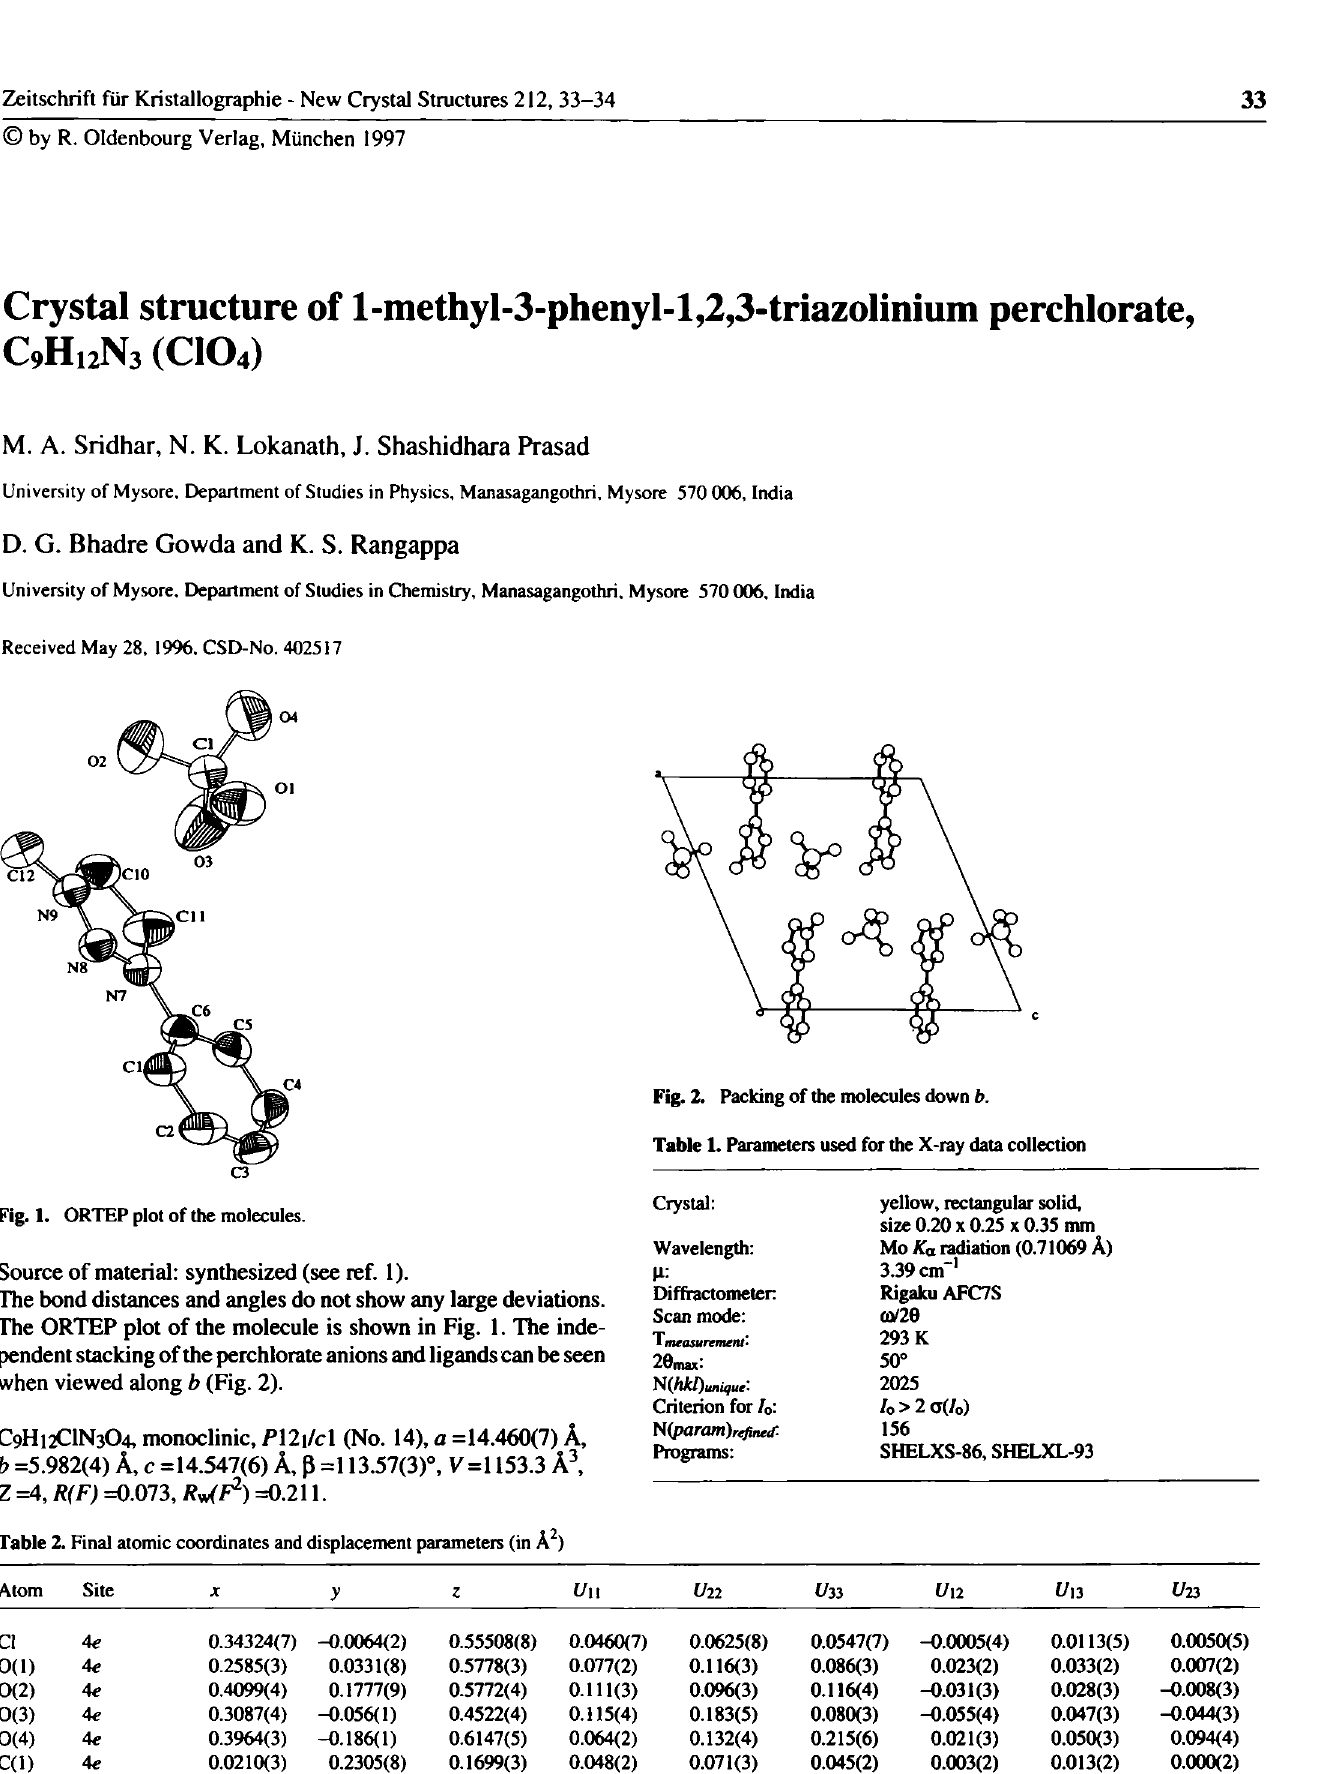
Table 2. Final atomic coordinates and displacement parameters (in Â 2 )